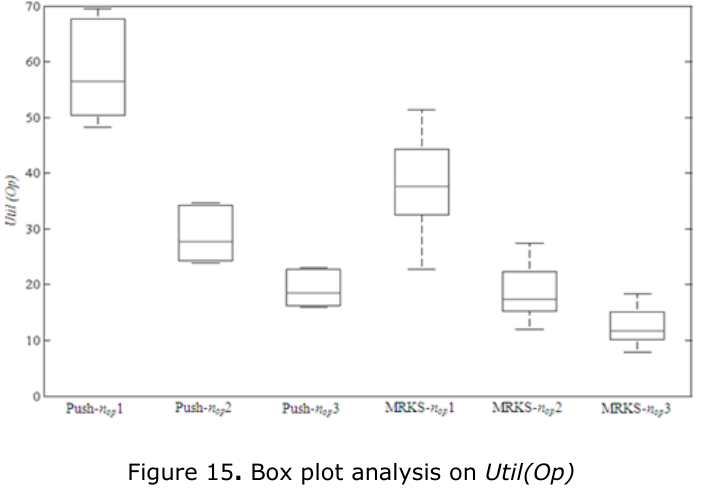
Figure 15 . Box plot analysis on Util(Op)